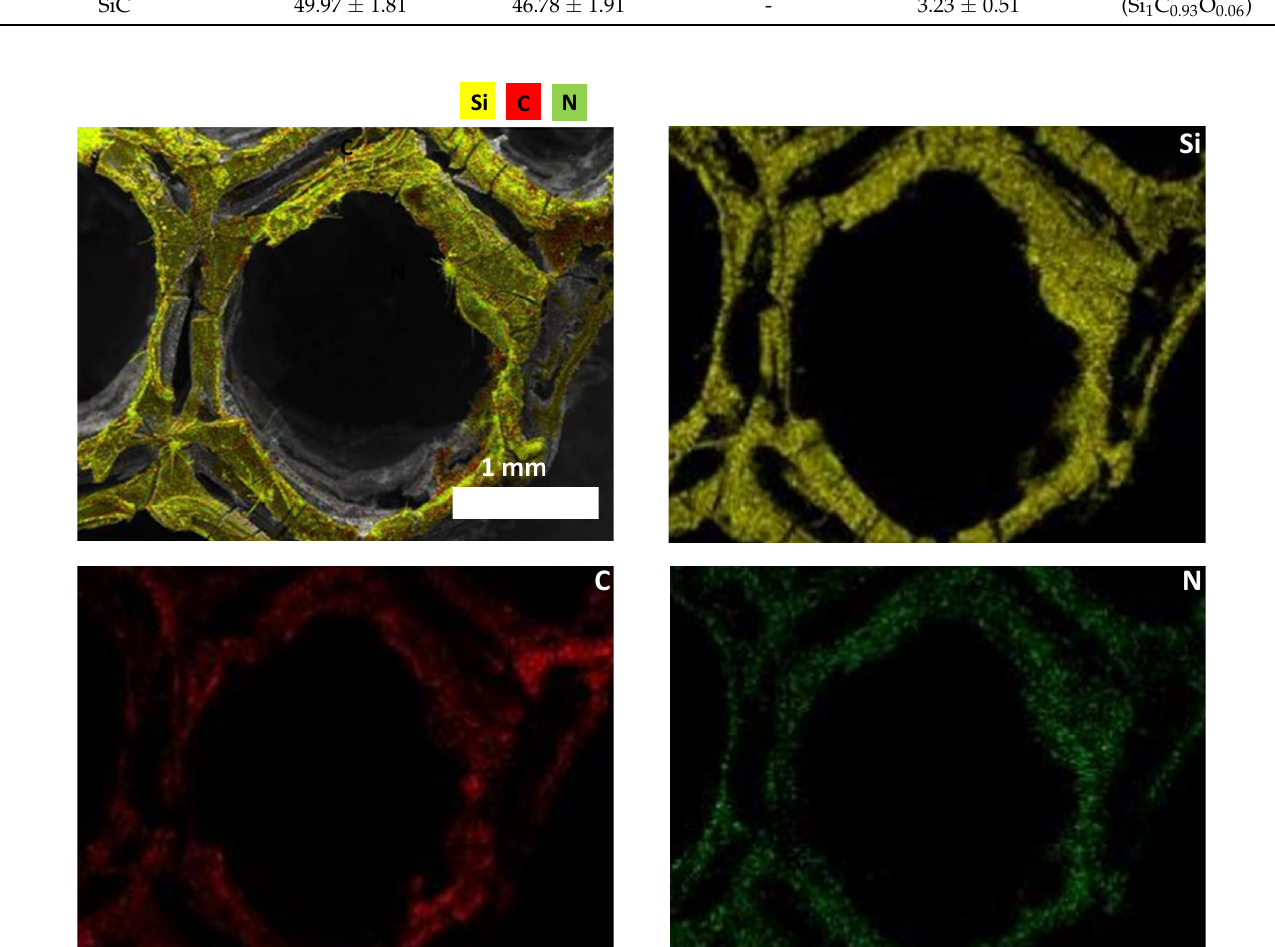
O Figure 4. Elemental mapping of 3D